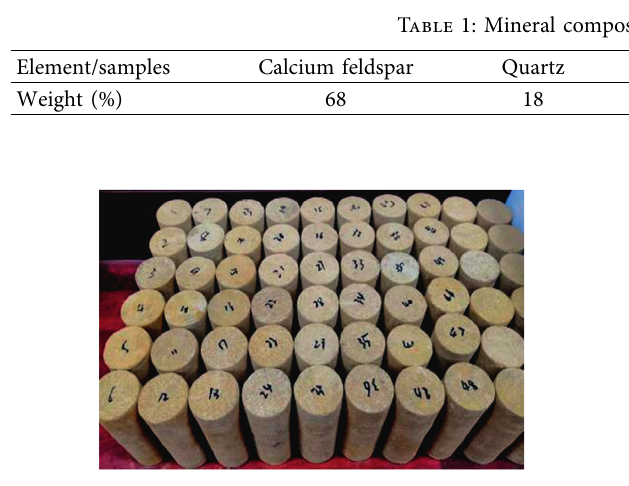
Figure 1: Part of the standard sandstone samples.